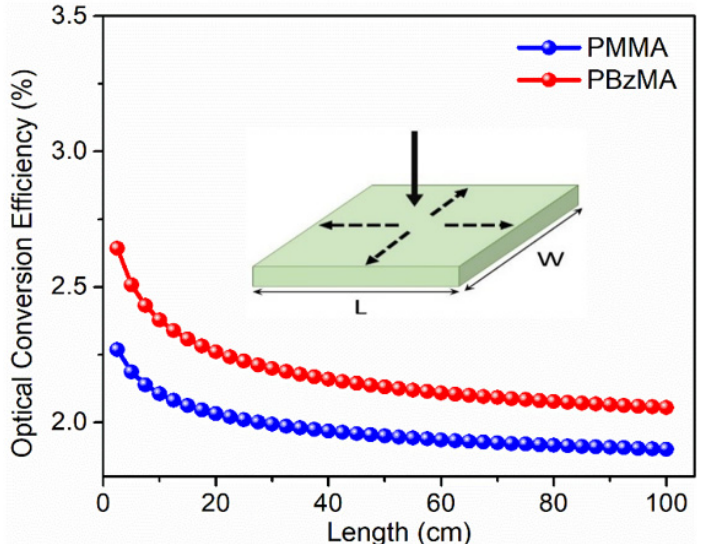
Figure 6. Calculated optical conversion efficiency of DACT-II-based LSCs with PMMA and PBzMA matrices. For all η opt values, the LSCs were assumed to be in square shape (length = width).